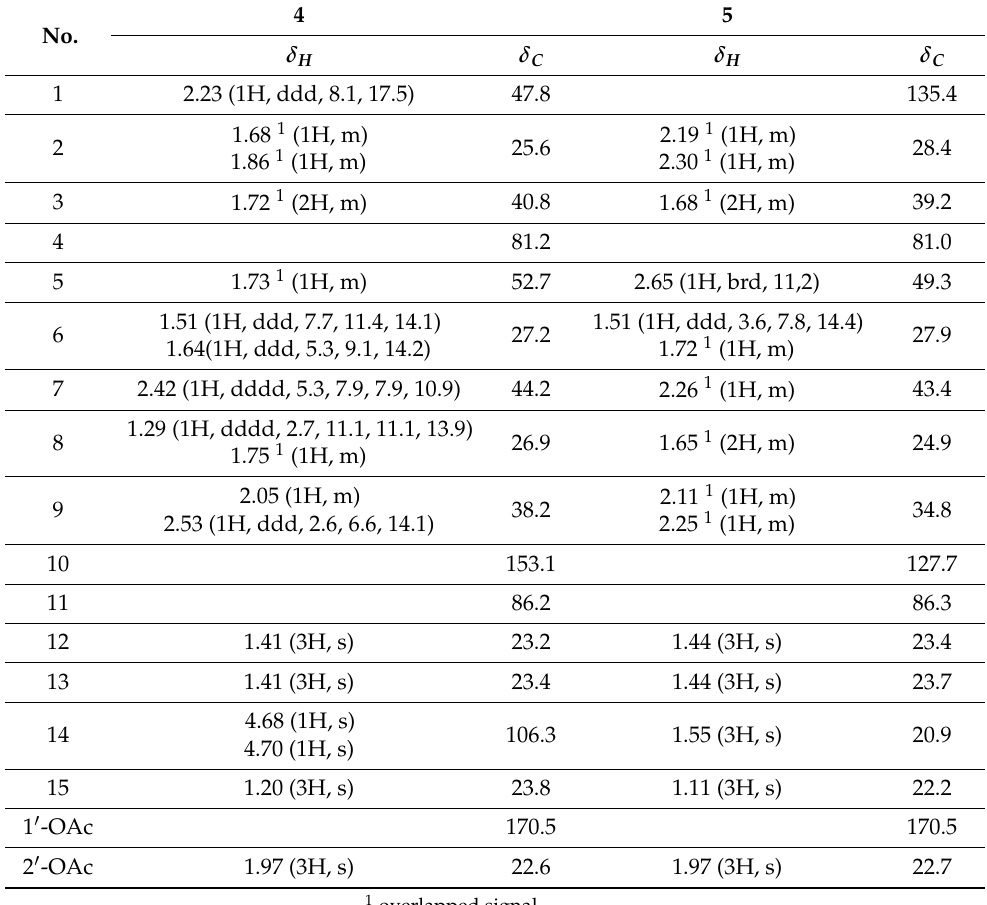
Table 2. 1 H and 13 C-NMR data (400 and 100 MHz, respectively; CDCl 3 , δ in ppm, J in Hz) for compounds 4 and 5 (s singlet, d doublet, br broad, m multiplet).